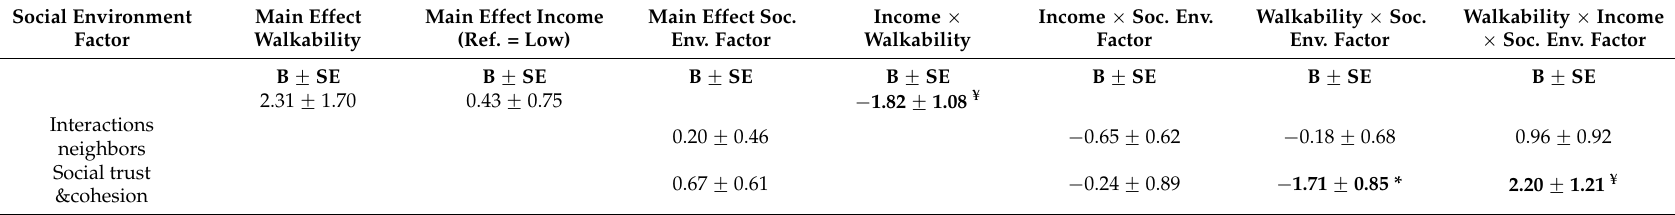
Table 2. Multivariable model for associations between social environment factors and MVPA, and interactions with neighborhood walkability and income.